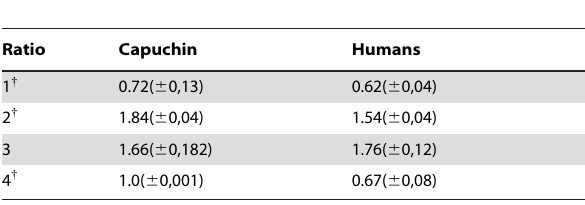
Ratios: 1. longitudinal axis/transversal axis; 2. longest curved axis of the carpus/ transversal axis of the carpus (including pisiform bone); 3. longest curved axis of the carpus/transversal straight axis of the carpus (excluding pisiform bone); 4. longest axis from carpus to trapezium bone/longitudinal axis of the